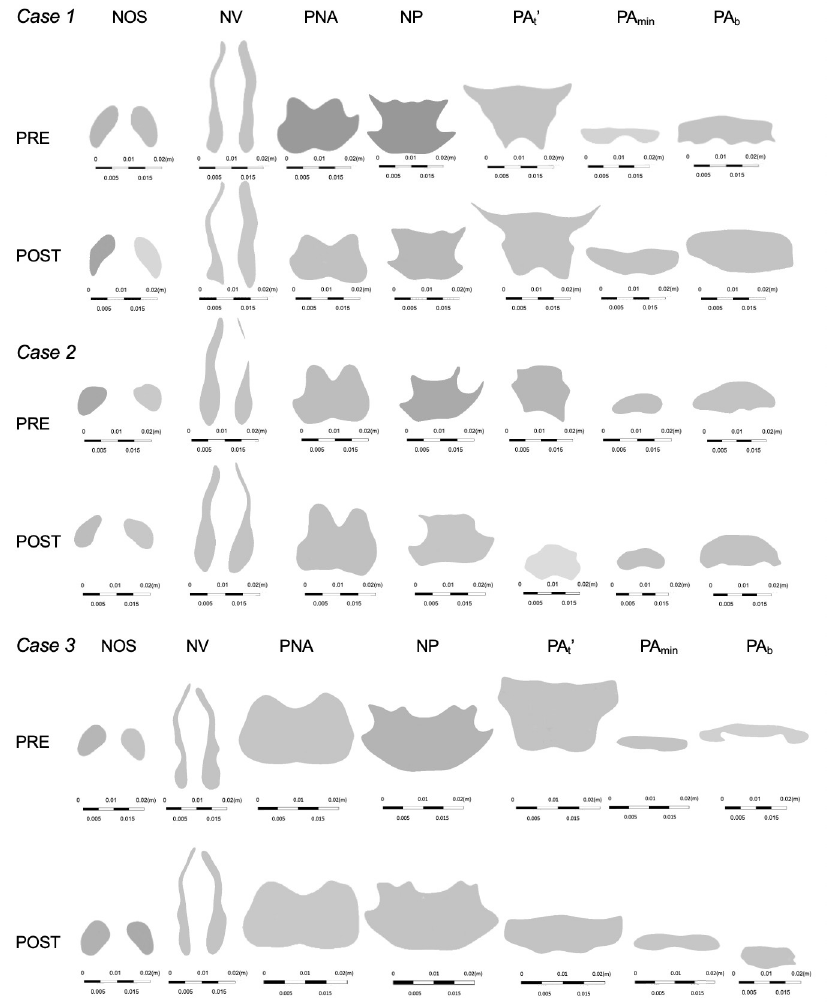
Fig 8. Cross-sectional shape of the upper airway. Cross-sectional shape of the upper airway in patients 1, 2 and patient 3. interval is low due to a Δ P, whereas the flow velocity in the B-C interval is high due to an increase in the Δ P (albeit without flow-separation zones). This separation leads to a signifi- cantly higher amount of energy loss, in addition to airway resistance, depending on the size of the cross-section due to vortices created downstream of the separation point by reflux. Accord- ing to the results of this study, separation and vena contracta in the narrower area (equivalent to the A-B interval in Fig 12) and separation and turbulent flow in a wider area (equivalent to the B-C interval in Fig 12) resulted in a Δ P due to turbulent flow in Δ P , as seen in the Pharynx STENOSIS -15 mm model of patient 1 and STENOSIS -10 mm model of patient 2 in Fig 11. On the other hand, the changes in Δ P were insignificant due to a significant Δ P caused by vis- cosity due to the tapering of the pharyngeal airway toward the narrowest part of the pharynx in the POST/STENOSIS models of patients 2 and 3. Previous studies [30, 37] examined the CSA of stenosis of the upper airway, but failed to evaluate the changes in the pre- and postop- erative diameters of the upper airway. Yajima et al. [30] found that the Δ P increased